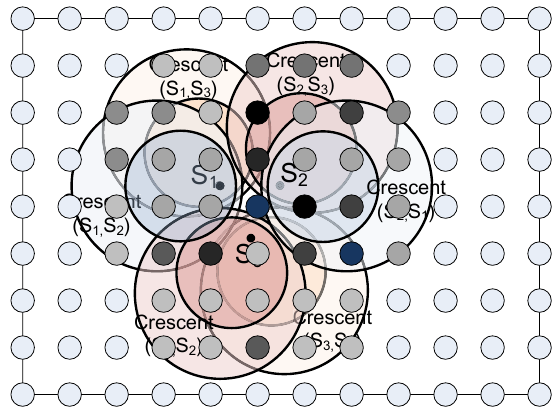
Figure 9. PGL Algorithm with 3 SN and 2 GW.